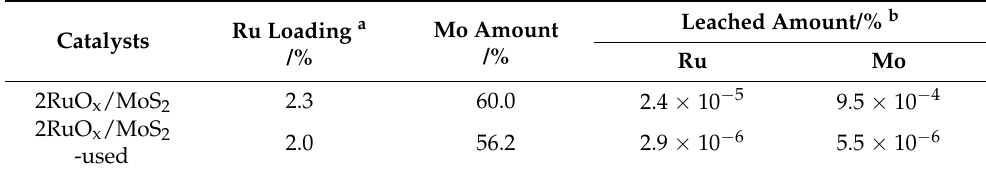
Table 3. Elemental analysis of catalysts and product solution by ICP-OES.